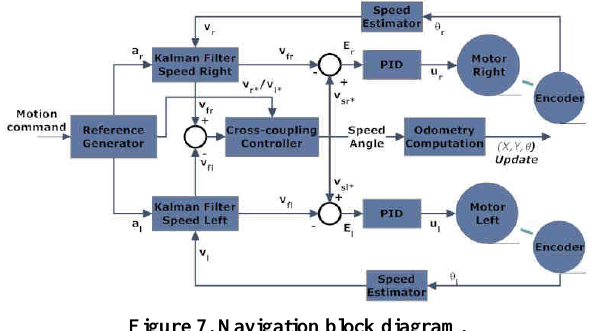
Figure 7. Navigation block